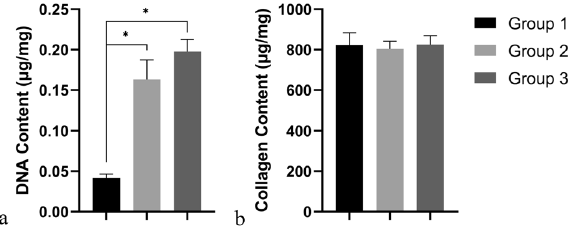
Fig. 7 DNA and collagen content of specimens after decellularization. *indicates statistical signi fi cance between bars ( p < 0.05)